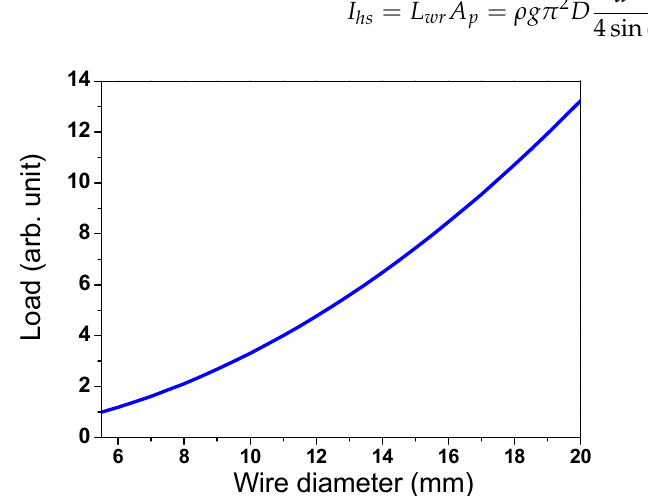
Figure 10. ( a , c ) Schematic and ( b , d ) calculated projection area of wire rod with contact angle and wire diameter.